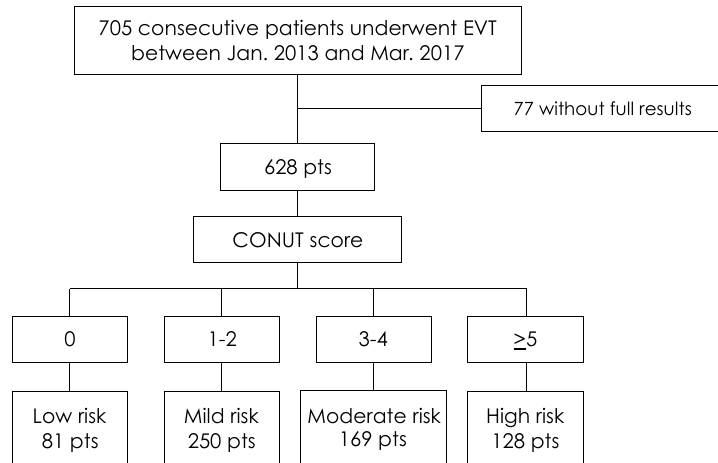
Figure 1. Study population. CONUT = Controlling Nutritional Status; EVT = endovascular therapy; pts = patients.